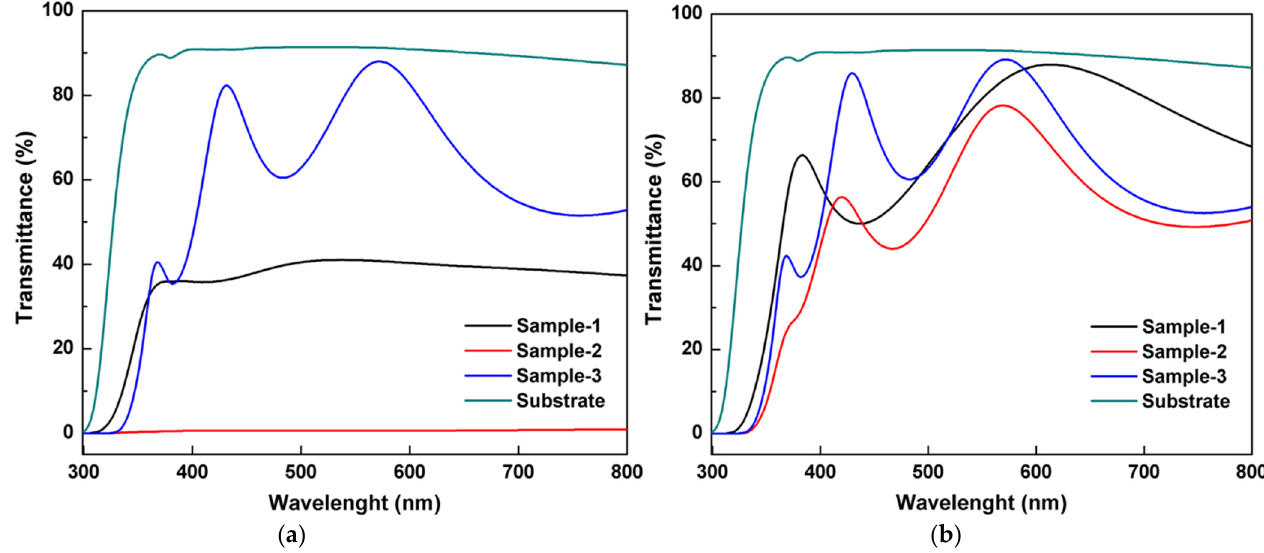
Figure 9. UV–VIS transmittance spectra of a thin film with different samples oxidized at ( a ) 450 ° C and ( b ) 550 ° C.